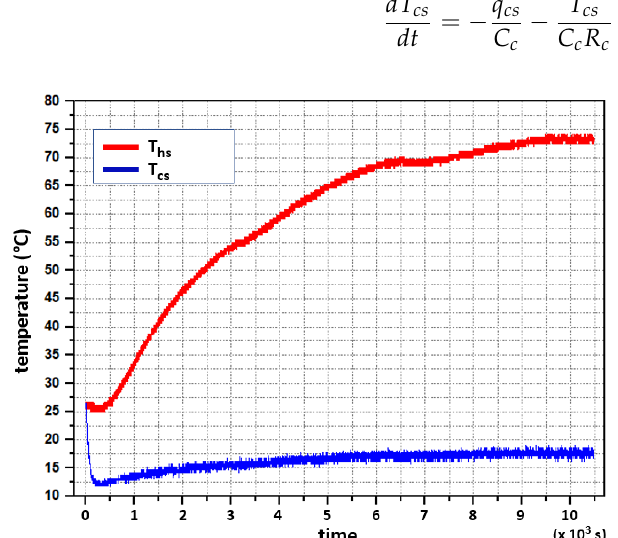
Figure 7. Experimental test. System’s response to a step input change in heating ( T hs ) and cooling ( T cs ) power from room temperature (26 ◦ C) up to 73 ◦ C in the hot side, and 17 ◦ C in the cold side.